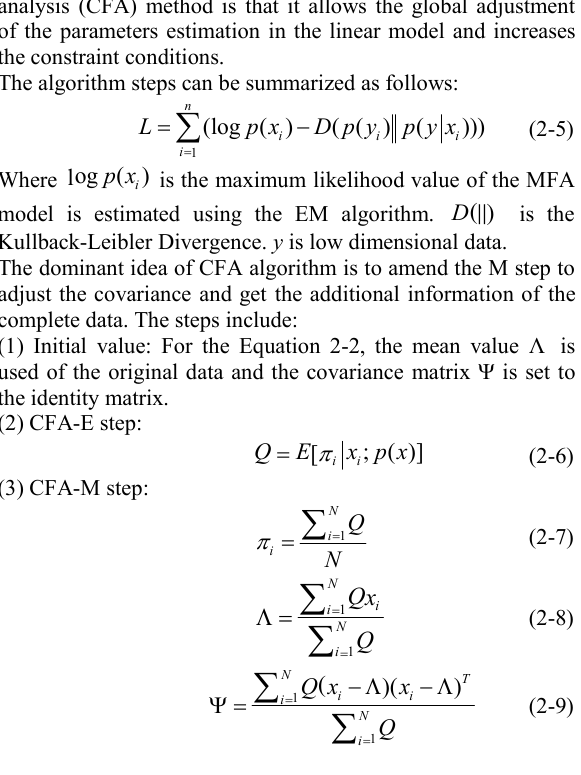
CFA algorithm(4) The condition of convergence: Keeping the iteration E and M steps and repeating the above three